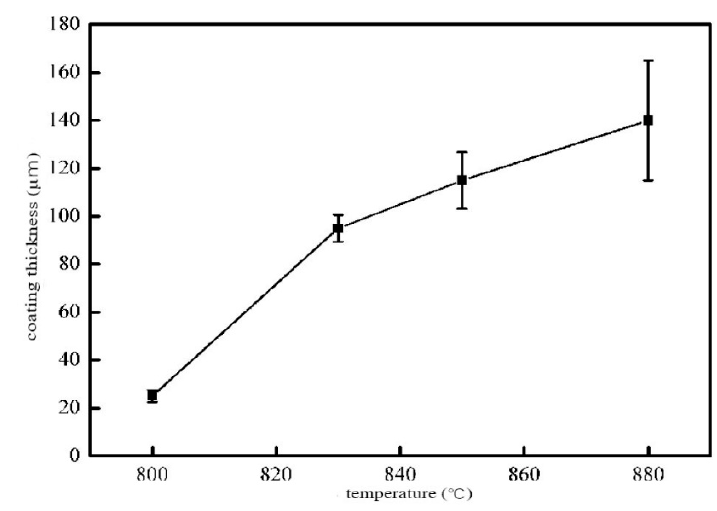
Figure 4. Aluminide layer thickness changing with aluminizing temperature.